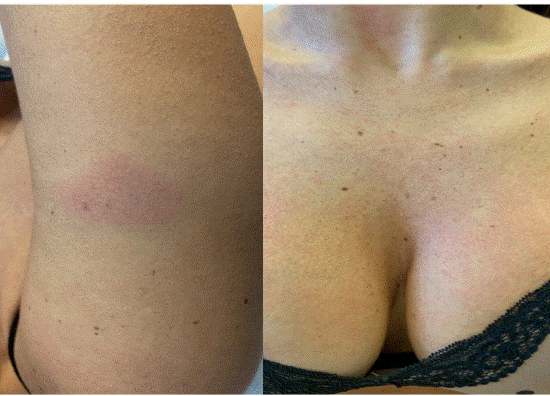
Figure 1. Urticarial rash: generalized itchy erythematous–edematous lesions after Pfizer BioNTech vaccine in the same patient.